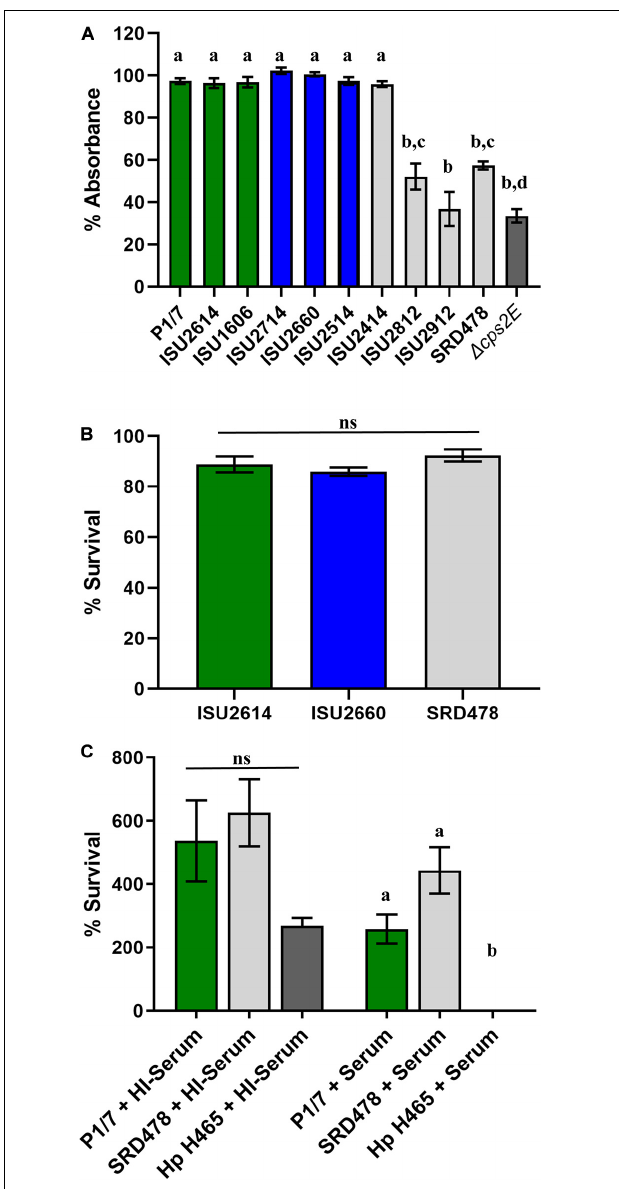
FIGURE 4 | Comparison of phenotypes related to capsule production. (A) Bacterial hydrophobicity assay. Relative hydrophobicity of S. suis isolates were determined by measuring their absorption ( y -axis) to n-hexadecane. S. suis P1/7 (cid:49) cps2E , a capsule deletion mutant, was used as a control. (B) Whole blood sensitivity assay. S. suis isolates were incubated with swine whole blood for 1 h and enumerated to determine the percent viable bacteria ( y -axis) expressed. (C) Serum sensitivity assay. Bacteria were incubated with guinea pig serum (+Serum) or heat-inactivated guinea pig serum (HI + Serum) and enumerated to determine the percent survival ( y -axis) calculated as the proportion of treated samples to untreated samples. Serum-sensitive Glasserella parasuis H465 (Hp H465) was used as a control. Bars represent means ± SEM from three independent experiments. Bar color reflective of virulence categorization (green: highly virulent; blue: moderately virulent; light gray: non-virulent) or control (dark gray: S. suis P1/7 (cid:49) cps2E ). Data was analyzed using a one-way ANOVA with a Tukey’s post-test (GraphPad Prism 8.3.0). Groups with different letter designations were significantly different ( p < 0.05); ns, not statistically significantly